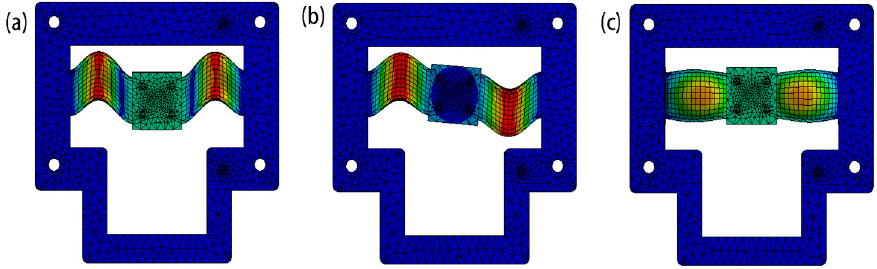
Figure 8. First three modes of the nanopositioner model. ( a ) 1st mode; ( b ) 2nd mode; ( c ) 3rd mode. Table 3. ANSYS results for the frequency modes in the absence of an applied magnetic field.